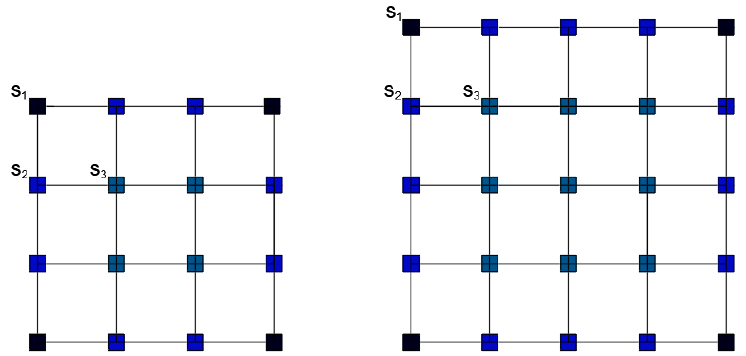
Figure 6. Location of columns S 1 , S 2 and S 3 in plan, whose cross-sections are calculated for three-span and four-span building models.